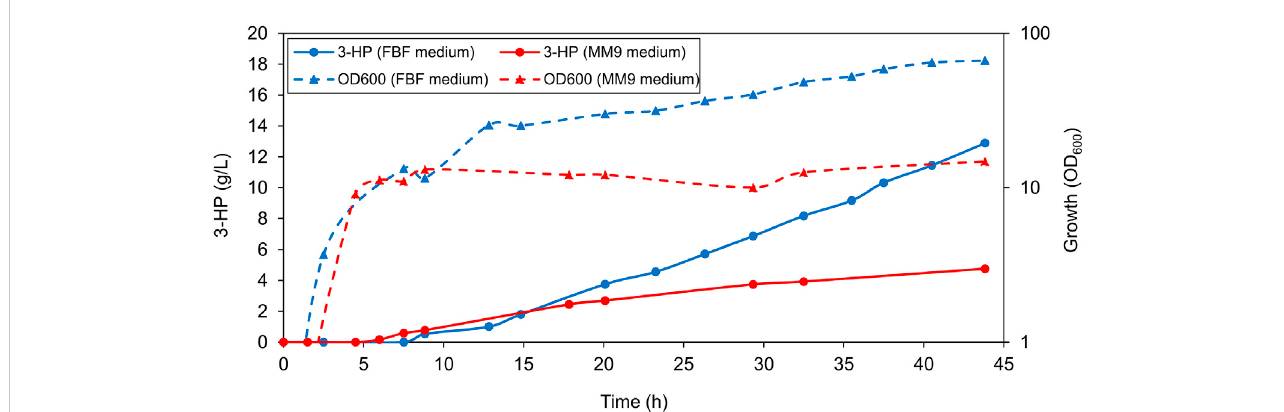
FIGURE 1 Production of 3-HP in a 1-L bioreactor. Representative graph depicting the concentration of 3-HP and cell density (OD 600 ) values of PS grown in fermentation medium compared to the modi fi ed 2x M9 medium throughout the 44-h growth period. Cells grown in the fermentation medium exhibited a higher maximum optical density (OD 600 ) as well as a higher 3-HP